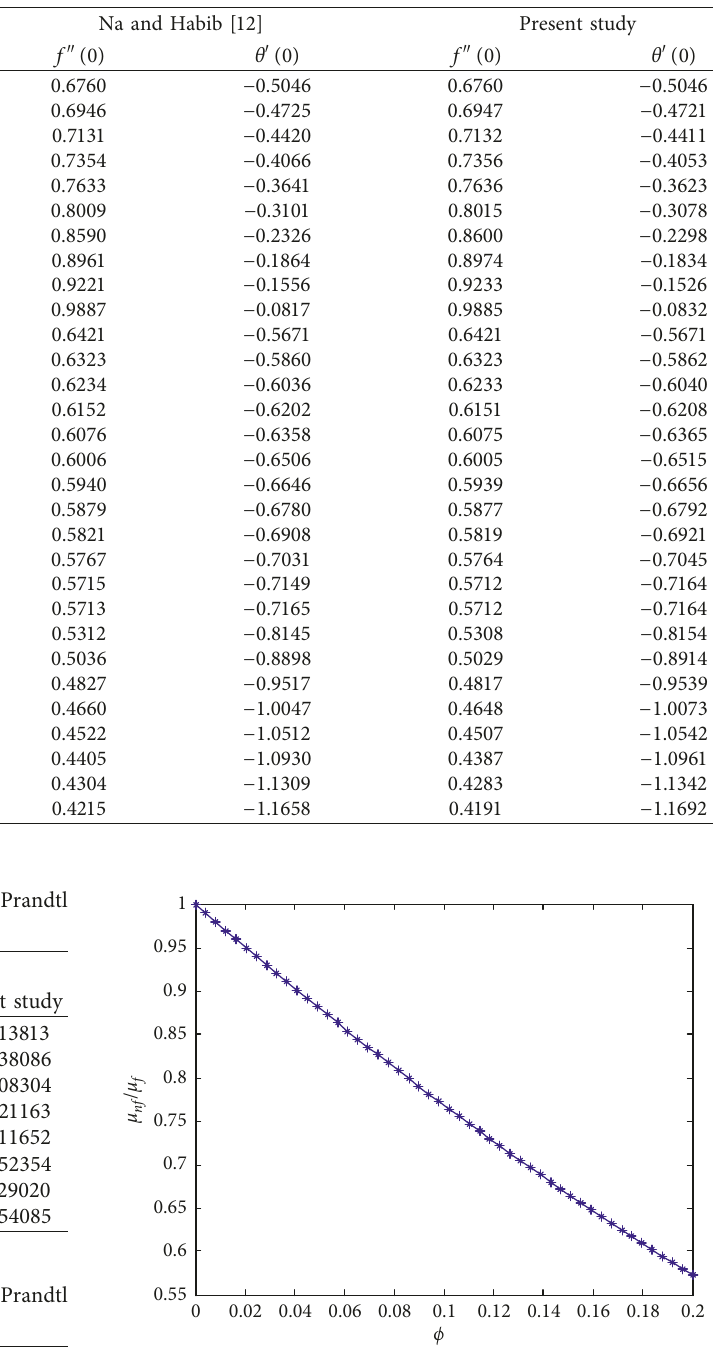
Figure 2: Variation in nanofluid dynamic viscosity ratio with nanoparticle volume